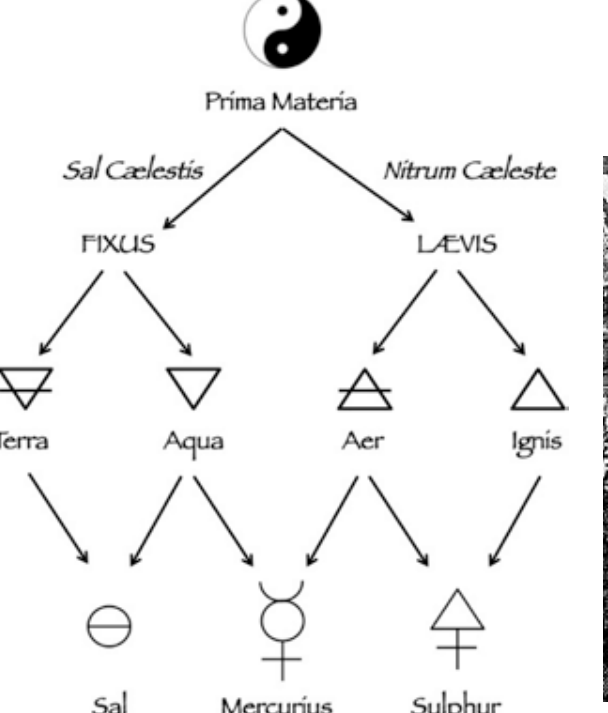
Figure 3. Michael Maier, Atalanta Fugiens – Emblem XXXVI. See Ref.